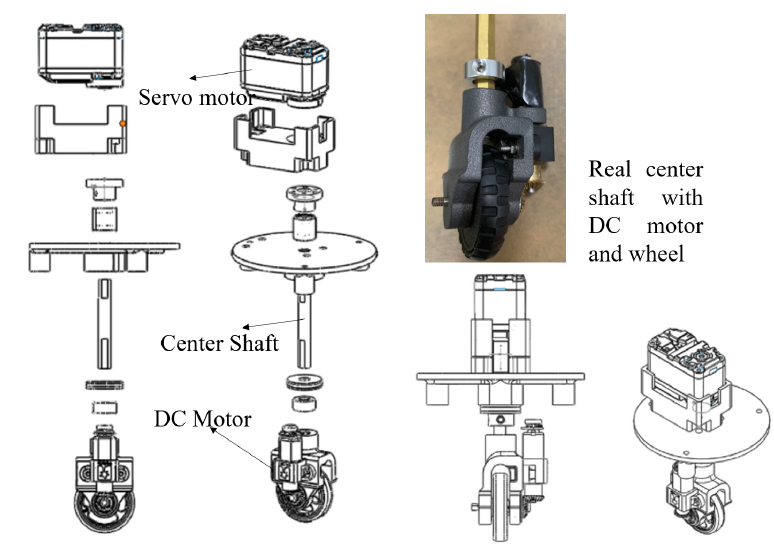
Figure 3. Independently-controlled steering and driving Locomotion